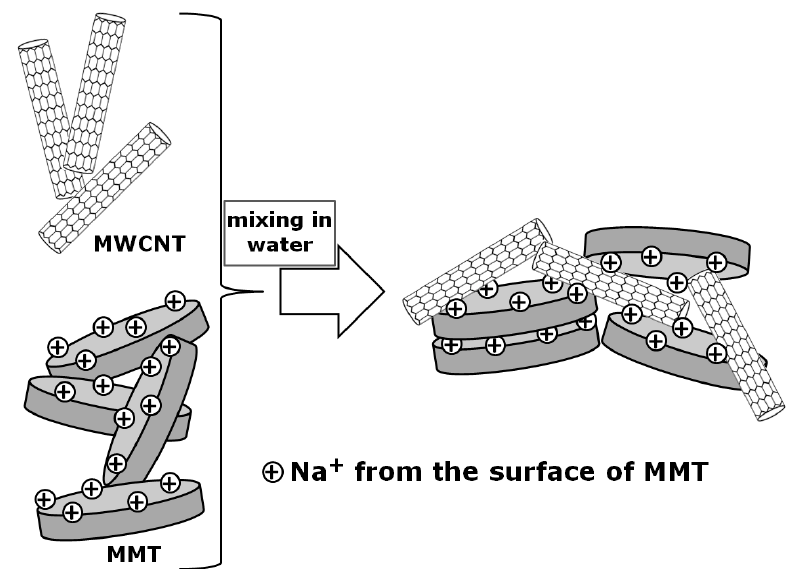
Figure 2. Schematic showing the interaction between MWCNTS and MMT nanoplatelets in